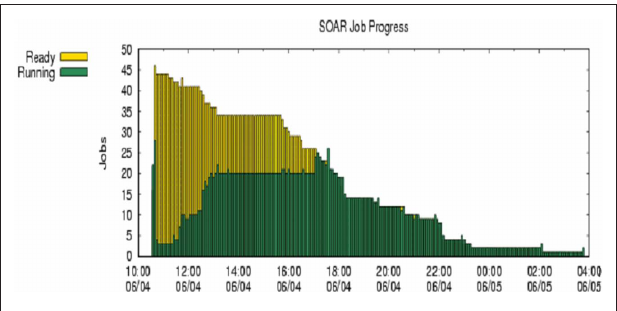
FiGure 6 | running and waiting time in parallel computing for prediction of genetic merit using candidate genes for 15 quantitative traits, each with three alternative methods for feature selection. Here, x -axis represents time of computing, and y -axis represents number of jobs pending (yellow bars) and number of jobs running (green